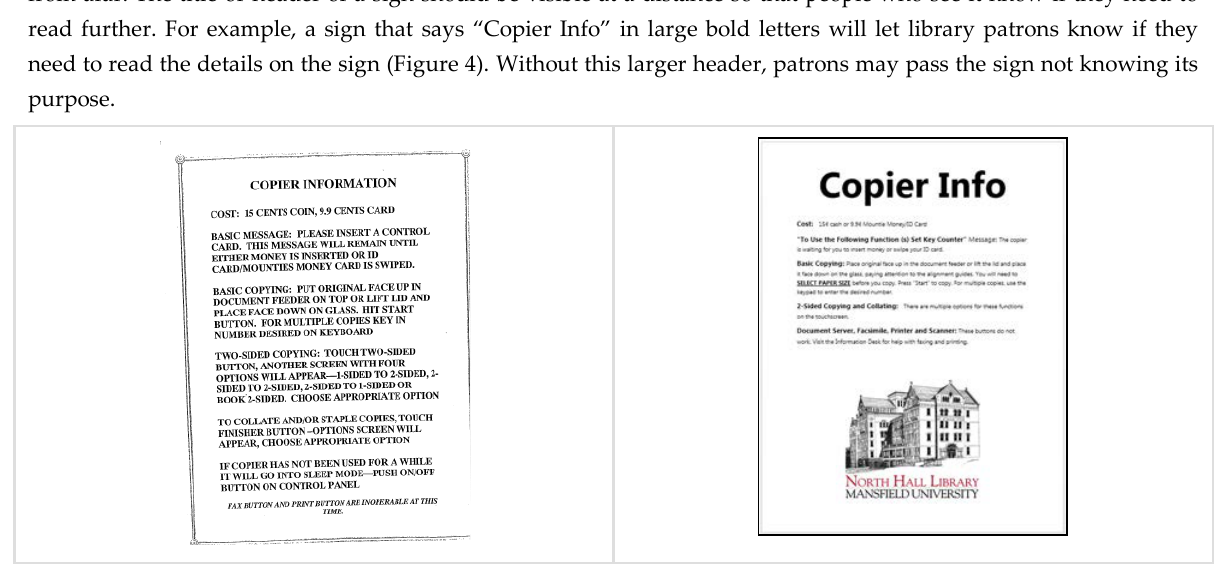
The original sign (left) is in all caps, and there is little contrast between the title and the text. It is difficult to see at a distance what this sign is about. The redesigned sign (right) uses a much larger title to draw attention to its purpose. It also uses slightly larger and bolder section headers for the detailed information. The logo makes it recognizable as an official library